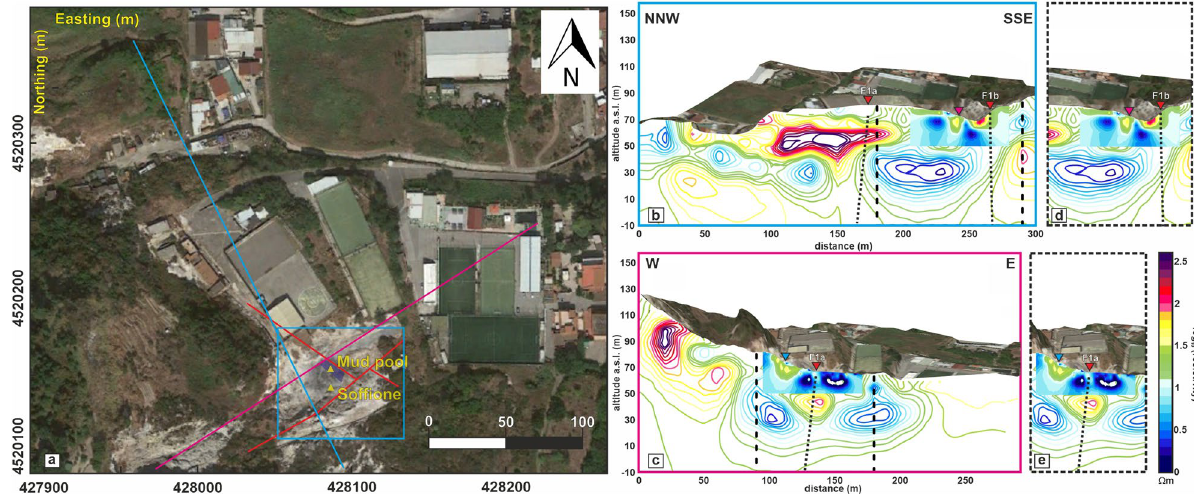
Figure 7. ( a ) Aerial view of Pisciarelli. The cyan and magenta solid lines indicate the alignments of two of the three geoelectrical profiles presented in ref. 9 . The cyan box encloses the area resolved by the present 3D high-resolution ERT. The red lines indicate the two main fault systems crossing the area (redrawn from ref. 9 ). ( b ) 2D resistivity section relative to the cyan transect in panel ( a ), drawn as color contours. A 2D resistivity section extracted from the ERT model of Fig. 2 is superimposed as filled contours. The red triangles and black dotted lines indicate the F1a and F1b main fault systems detected in ref. 9 . The dotted black square encloses the part of the section magnified in panel ( d ). ( c ) 2D resistivity section relative to the magenta transect in panel ( a ), drawn as color contours. A 2D resistivity section extracted from the ERT model of Fig. 2 is superimposed as filled contours. The red triangles and black dotted lines indicate the F1a and F1b main fault systems detected in ref. 9 . The dotted black square encloses the part of the section magnified in panel ( e ). The figure was created using the MATLAB R2020b commercial software (https:// www. mathw orks. com/ produ cts/ MATLAB. html) and postprocessed using the Corel Draw 17 commercial software (https:// www. corel draw. com/ it/ produ ct/ corel draw/). The aerial view of Pisciarelli was produced by the Istituto Nazionale di Geofisica e Vulcanologia (INGV), Sezione di Napoli ‘Osservatorio Vesuviano’ (Curtesy of dr. Enrica